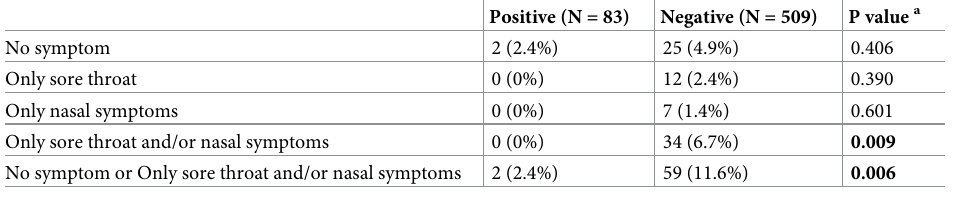
Table 2. SARS-CoV-2 test results in asymptomatic healthcare workers (HCWs) and HCWs with only nasal/throat